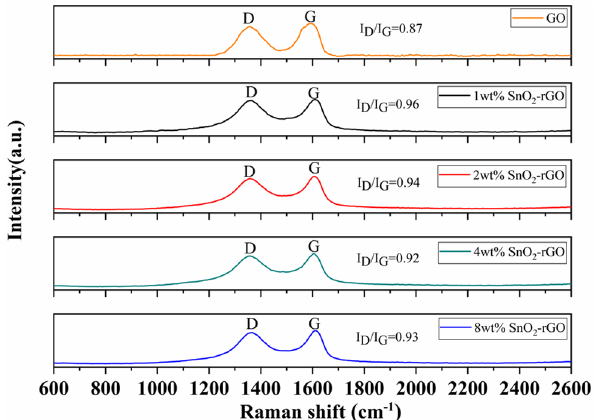
Figure 3. Raman spectra of GO and SnO 2 /rGO nanocomposites